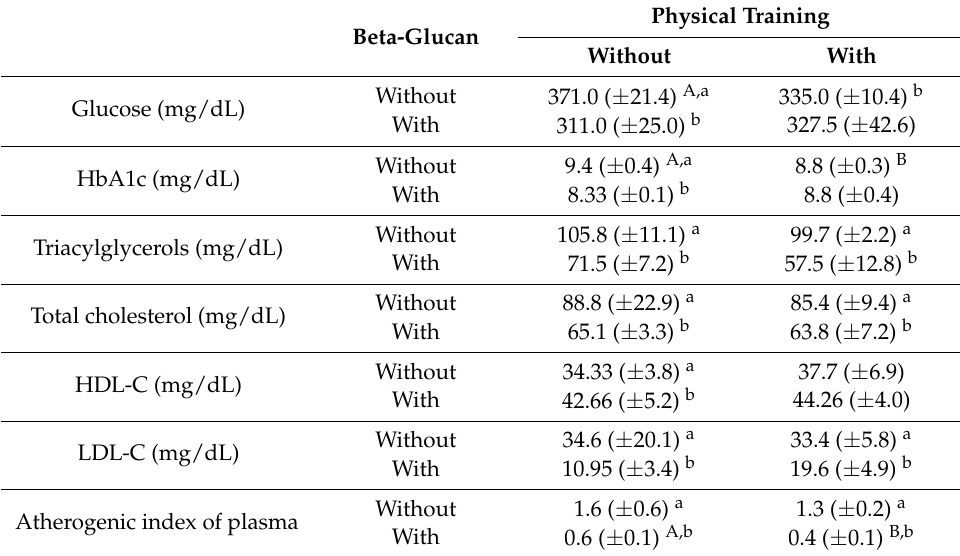
Table 1. Biochemical parameters and atherogenic index of plasma in type 2 diabetic rats (high-fat diet/streptozotocin) submitted to physical training and treated beta-glucan (30 mg/kg/day).